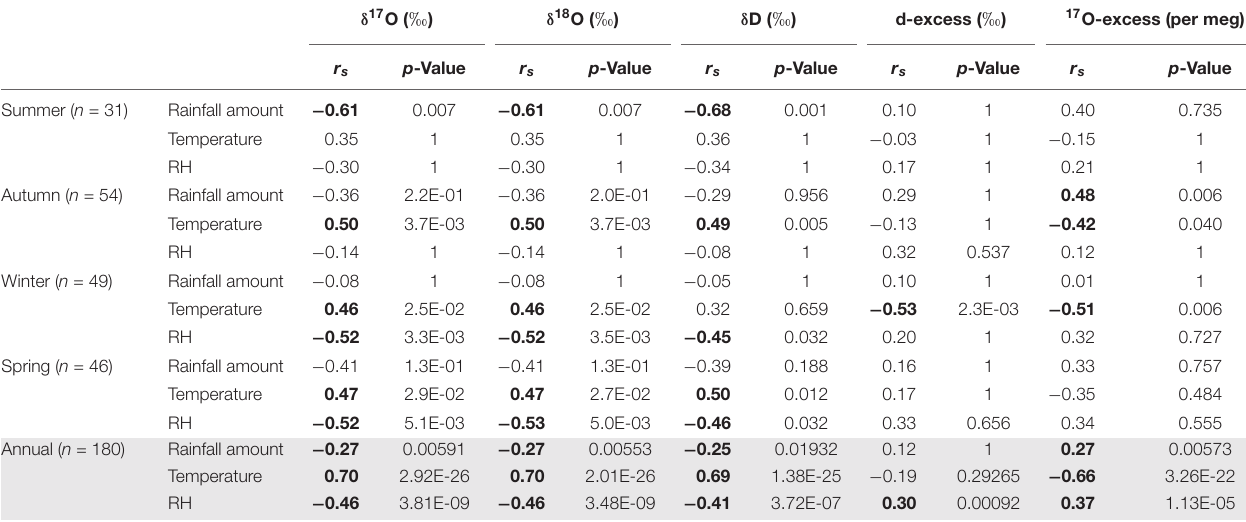
The number of events used for each correlation (n) is specified in the first column. Significant correlations with p-value < 0.05 after application of Bonferroni test are in bold.